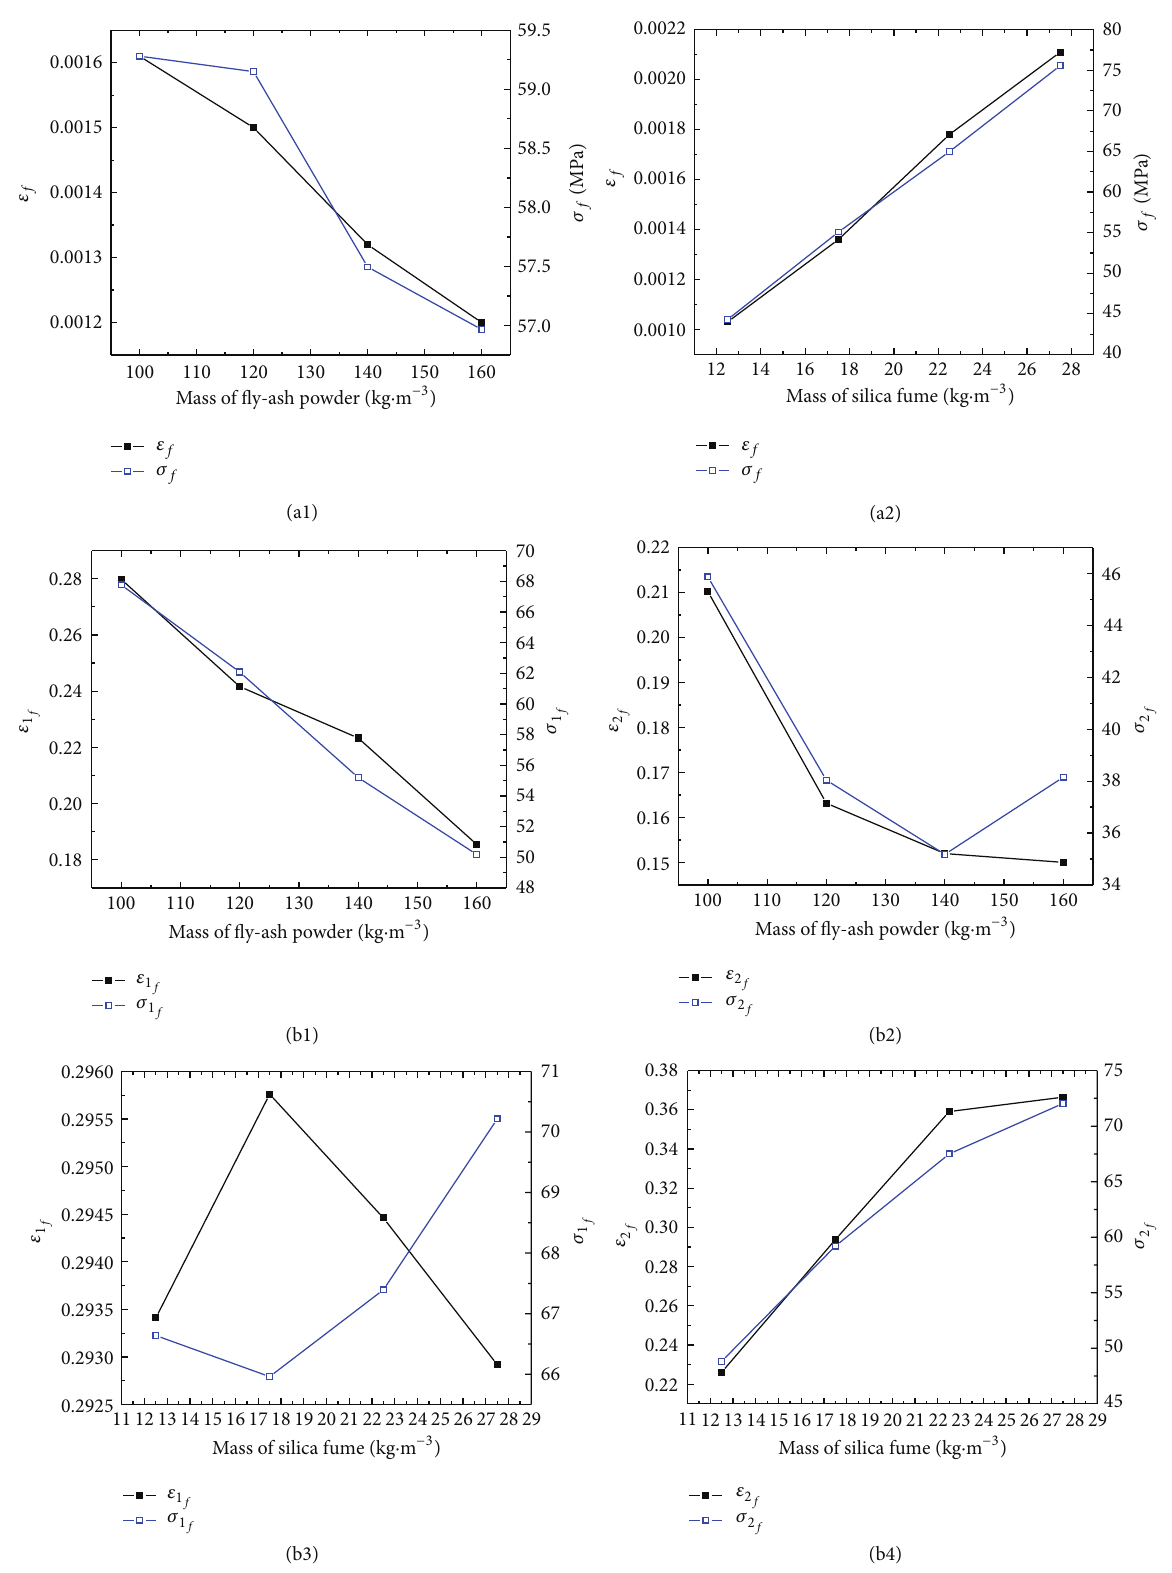
Figure 18: Peak strain and ultimate strength. (a1) Fly-ash powder case under uniaxial compressive loading condition, sample’s age: 28 days. (a2) Silica fume case under uniaxial compressive loading condition, sample’s age: 28 days. (b1) Fly-ash powder case under biaxial compressive loading condition, for vertical axis, sample’s age: 28 days. (b2) Fly-ash powder case under biaxial compressive loading condition, for horizontal axis, sample’s age: 28 days. (b3) Silica fume case under biaxial compressive loading condition, for vertical axis, sample’s age: 28 days. (b4) Silica fume case under biaxial compressive loading condition, for horizontal axis, sample’s age: 28